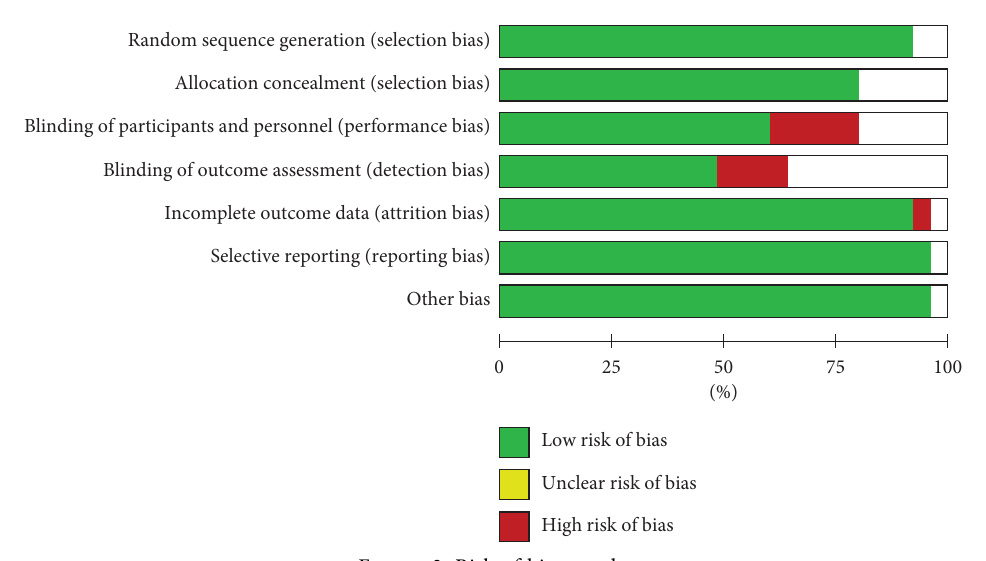
Figure 1: Flow diagram of study selection.